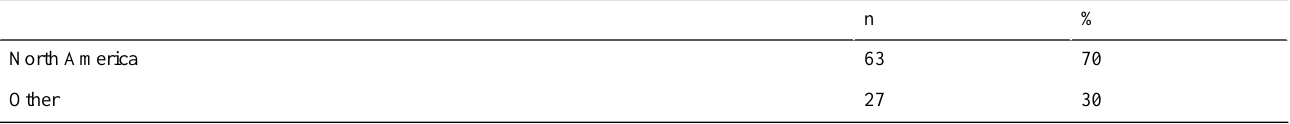
Table 4. MOOCs by North American universities versus worldwide